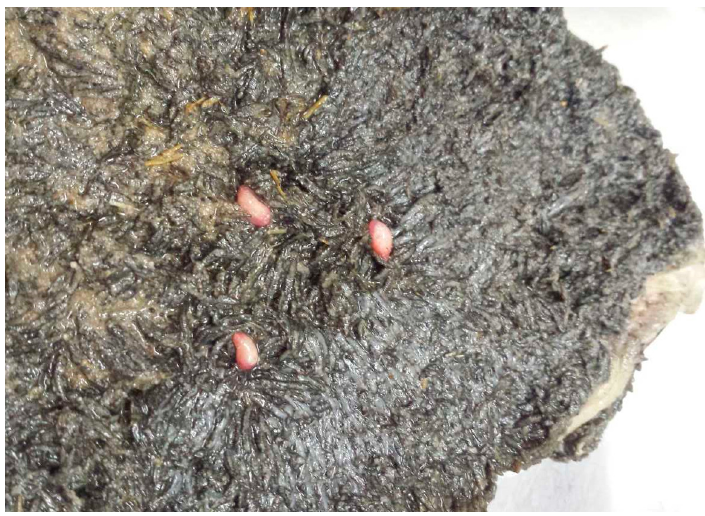
Figure 6. Adult flukes parasitizing in the